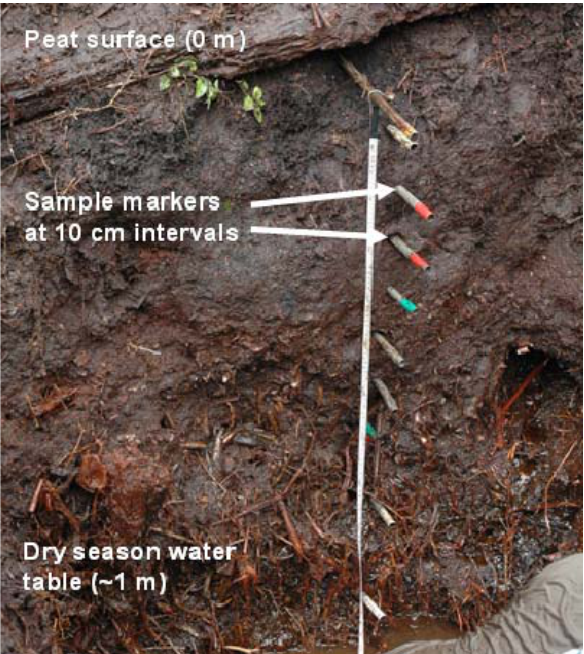
Fig. 2. Peat profile in an oil palm plantation, 18 years after drainage. The top peat is amorphous without visible plant remains, indicating advanced decomposition, while the peat below 0.3 m is increasingly fibrous going downwards, with abundant remains of wood and roots being evident below 0.5 m.